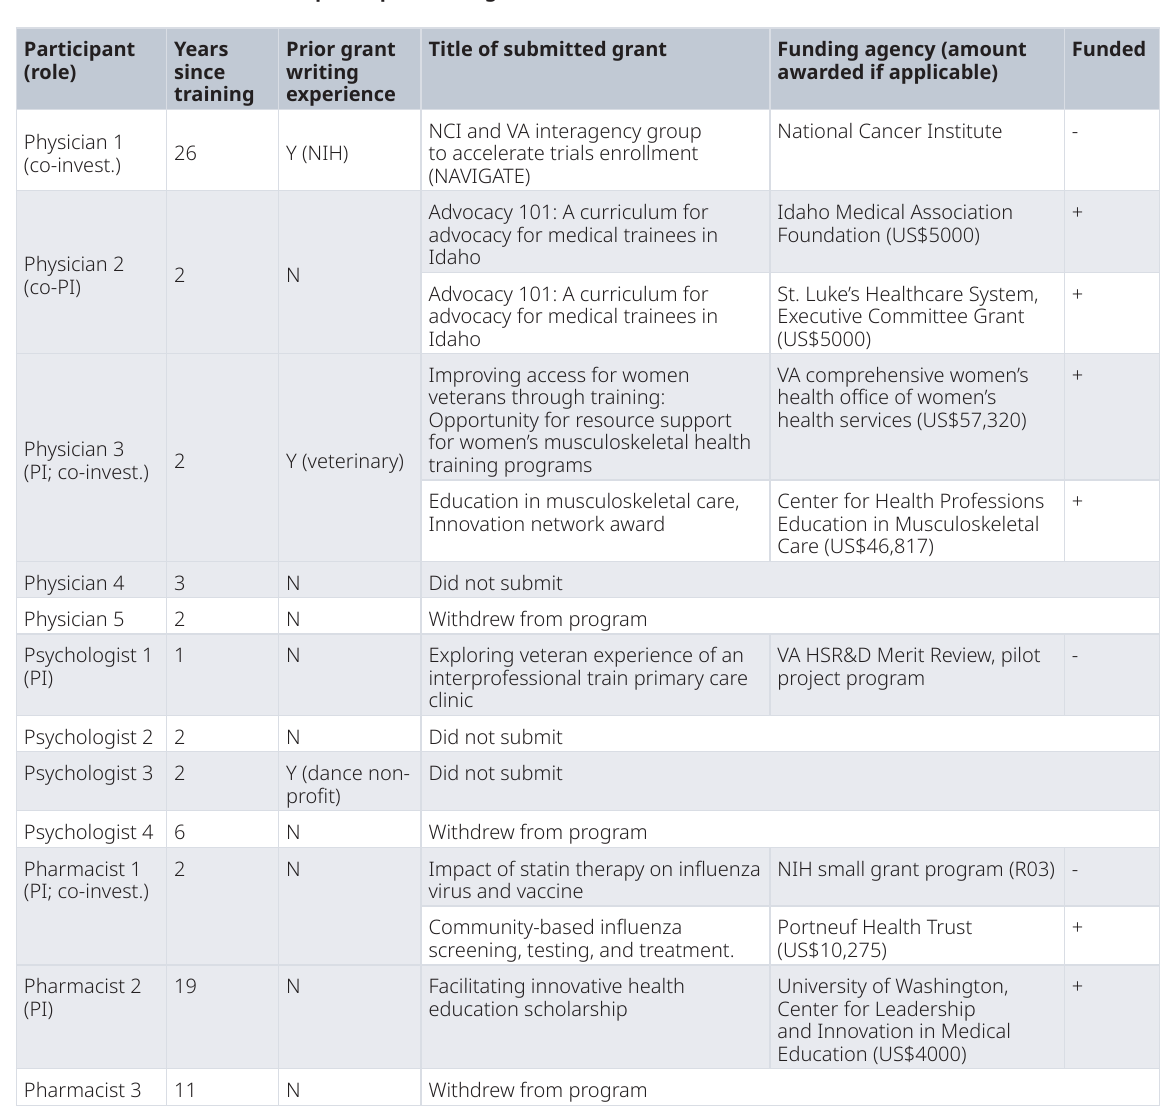
Table 2. Characteristics of the participants and grants submitted.